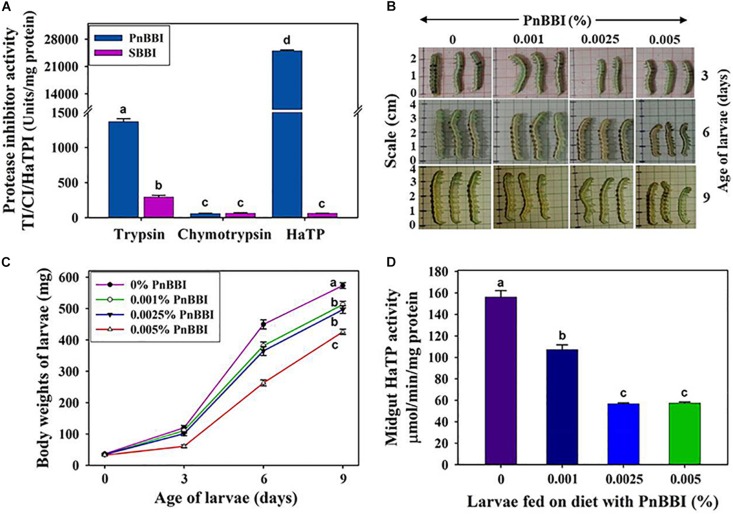
In vitro and in vivo inhibitory effect of PnBBI on larvae of H. armigera. (A) Comparative inhibitory profiles of PnBBI and SBBI toward bovine trypsin, chymotrypsin and HaTP; (B) Photographs depicting the reduction in size of larvae fed on increasing doses (0.001, 0.0025, and 0.005%) of PnBBI containing diet as compared to larvae fed on control diet at the end of 3, 6 and 9 days of feeding. A set of thirty number of second instar larvae with approximate equal body size and weight were used in the present study for feeding with each concentration of PnBBI; (C) depletion in mean body weights of larvae after feeding on diet containing PnBBI as described above; (D) variation in the activity of midgut HaTPs in larvae after feeding on diet containing PnBBI as described above. The data represented is mean ± SE of three biological replicates. Different lower case letters “a, b, c, and d” indicate statistically different at a significant level (P < 0.05) compared to control.